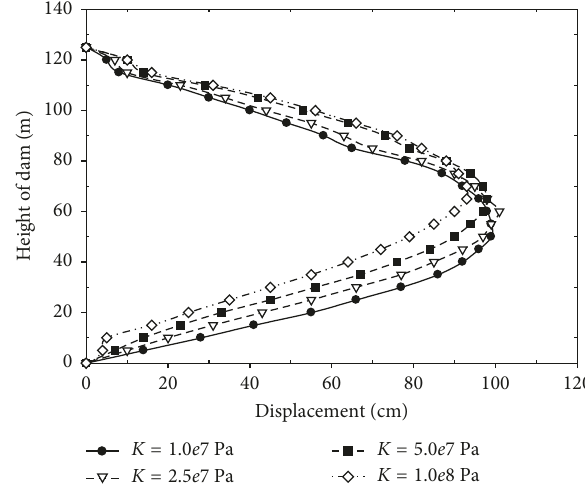
Figure 7: Comparing R u values for different bulk modulus of water.